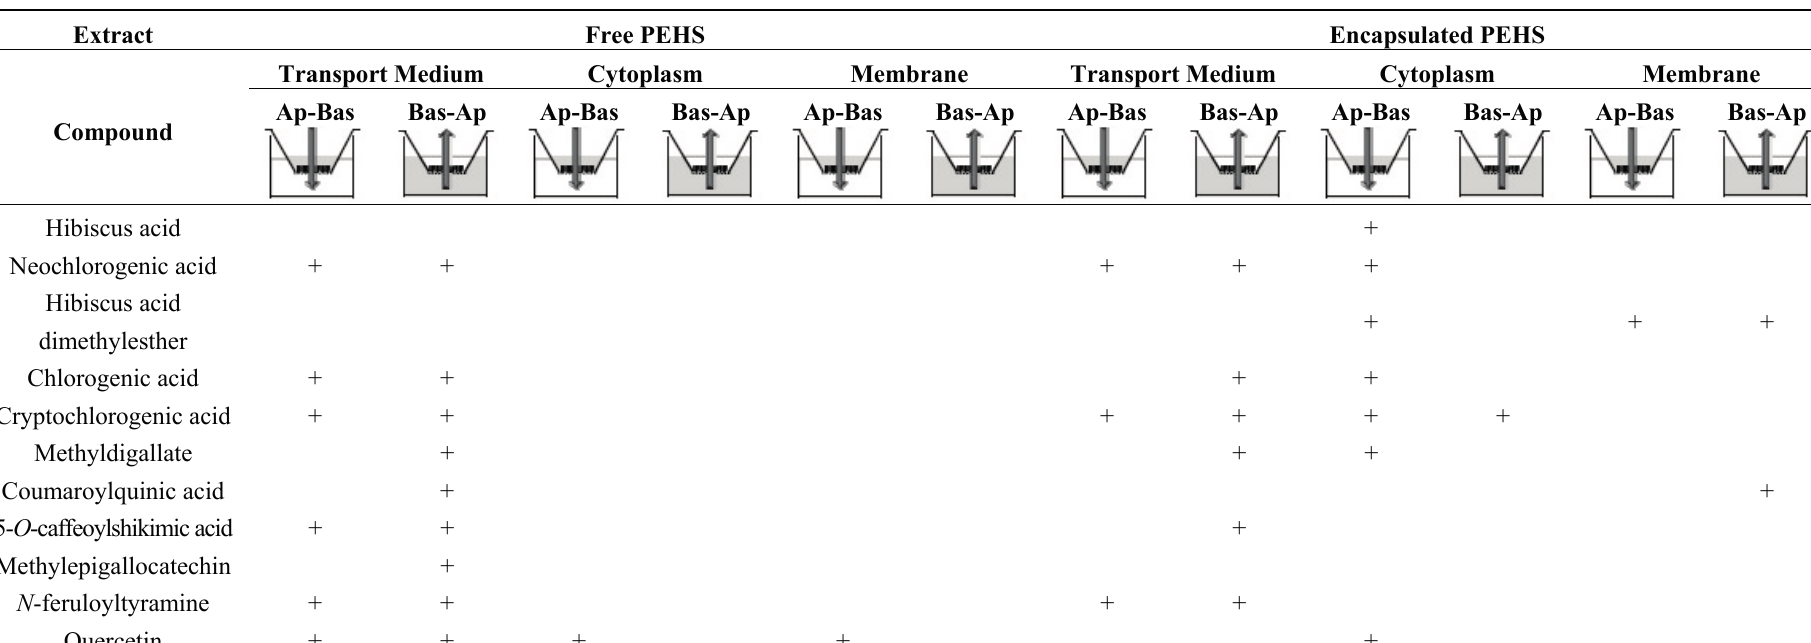
Table 2. Compounds detected in the transport medium, cytoplasm, and membrane obtained in apical to basolateral (Ap-Bas) and basolateral to apical (Bas-Ap) transport directions in the Caco-2 assay with the free and encapsulated PEHS. The symbol + indicated that the compound was